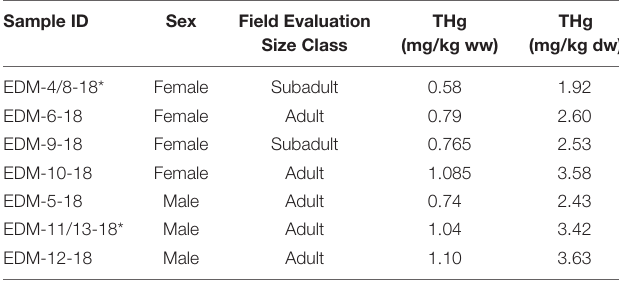
dolphins has been found to be MeHg (Stavros et al.,